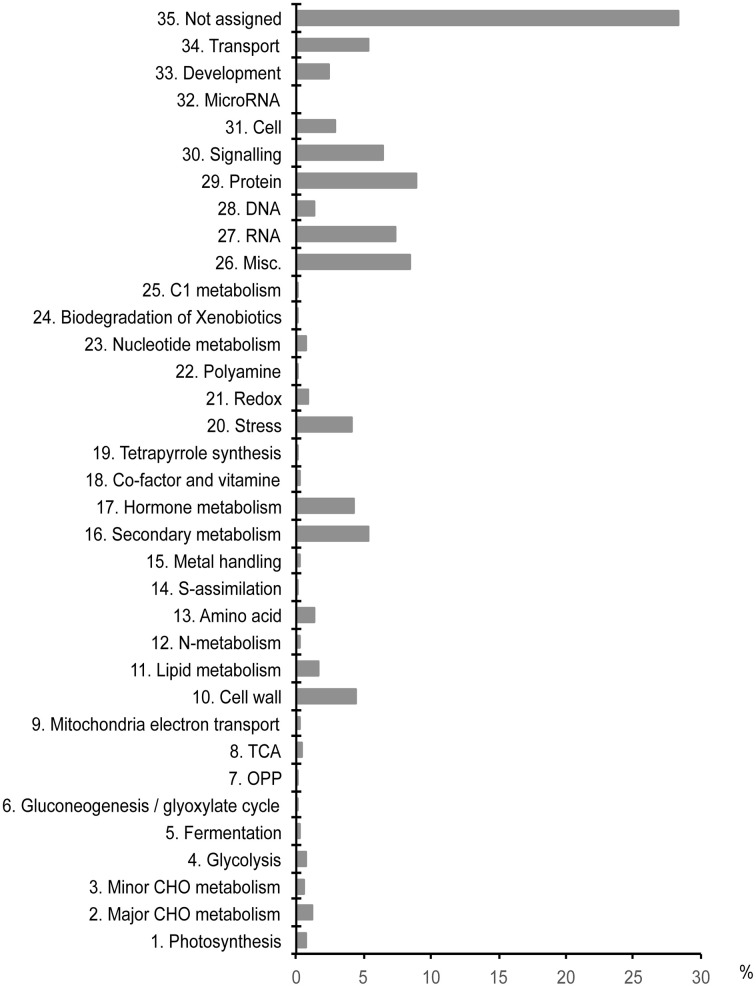
Functional classification of waterlogging-responsive DEGs. DEGs (1968 genes) were assigned into 35 functional bins using the Mercator annotation pipeline.